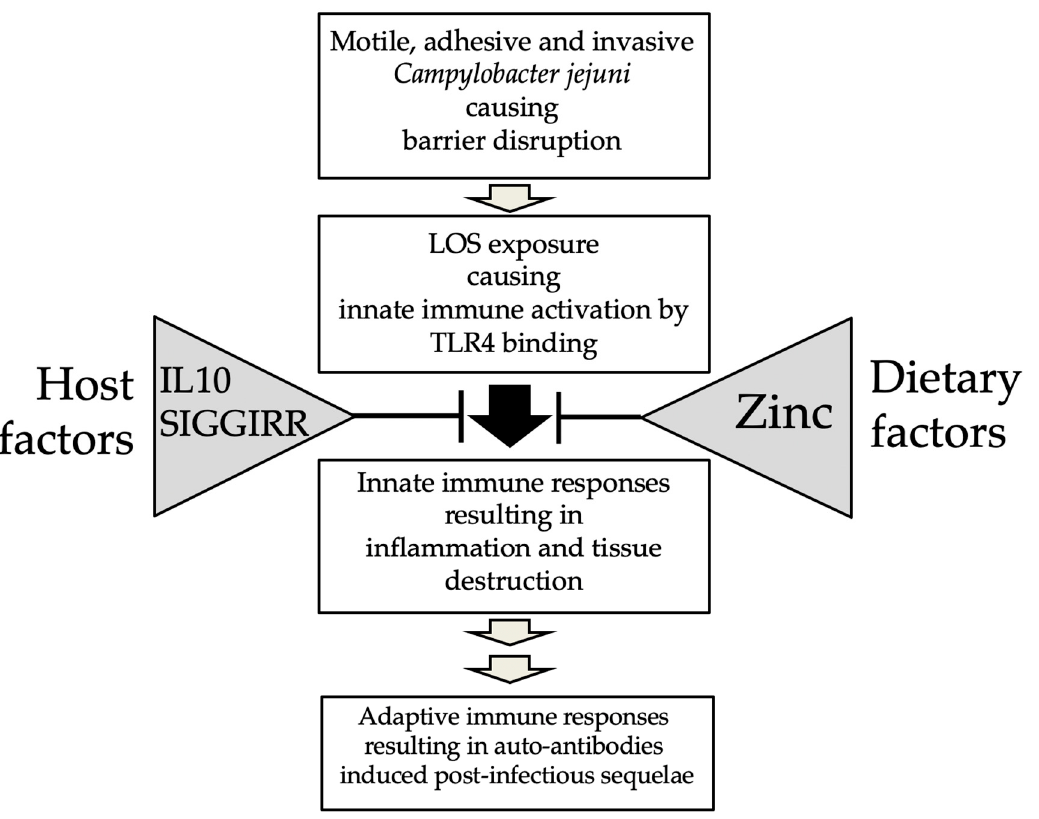
Figure 4. Modulation of Campylobacter jejuni infection by host and dietary factors. Both host and dietary factors interact with the immune responses upon C. jejuni infection at different levels thereby affecting the outcome of disease.